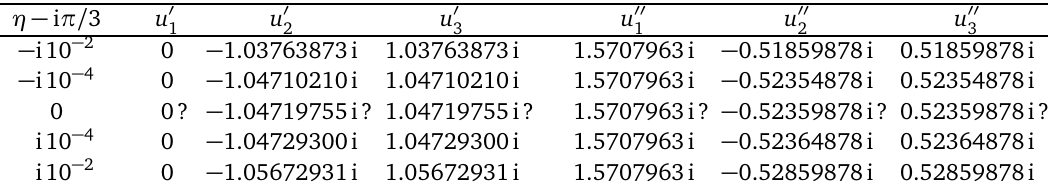
Table 4: The numerical Bethe roots of the two states at M = 3 with energy close to zero as η changes away from i π/ 3, including the values 0, ∓ i π/ 3 and i π/ 2, ∓ i π/ 6 (indicated with a question mark) that one would extrapolate as φ →